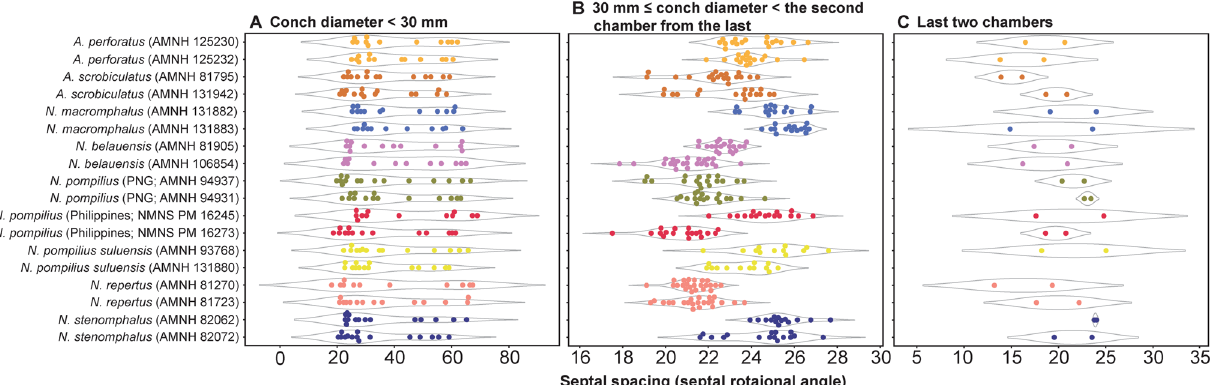
Figure 7. Range and distribution of septal spacing at different ontogenetic stages. ( A ) Early ontogeny (conch diameter < 30 mm). ( B ) Middle ontogeny (30 ≤ conch diameter < the second chamber from the last). ( C ) Late ontogeny (last two